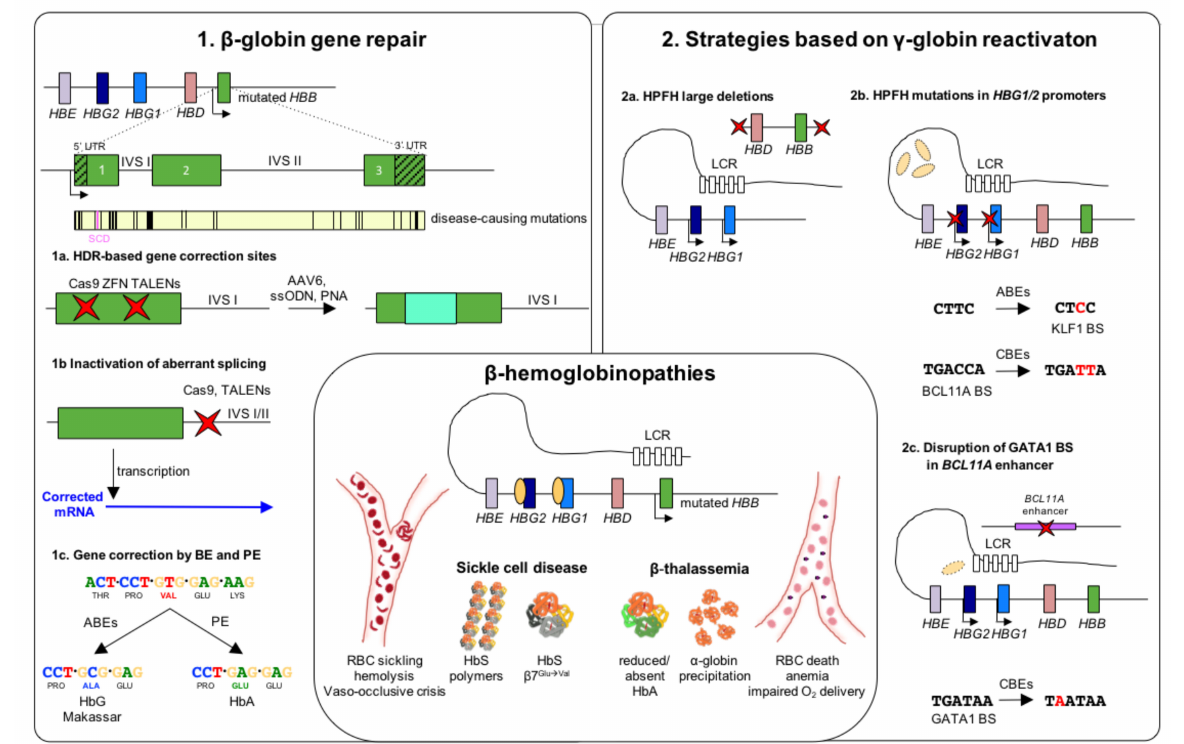
Figure 1. Genome editing strategies for β -hemoglobinopathies. β -hemoglobinopathy-associated variants in the β -globin locus cause the insufficient ( β -thalassemia) or abnormal (SCD) expression of β -globin. Reduced β -globin expression leads to globin imbalance and α -globin precipitation causing RBC death, anemia and impaired oxygen delivery. In SCD, a single amino acid substitution ( β 7 Glu → Val ) confers to the hemoglobin (HbS) a higher propensity to polymerize under hypoxic conditions, leading to RBC sickling, hemolysis and vaso-occlusive crises. ( 1 ). Strategies based on β -globin gene repair. Schematic representation of the β -globin gene including 5 (cid:48) and 3 (cid:48) untranslated region (UTR) and a map of the most common β -hemoglobinopathy-causing mutations. ( 1a ) Several genome editing approaches have been tested for repairing β -globin mutations through the homology direct repair (HDR) pathway. ( 1b ) Non-homologous end-joining (NHEJ) has